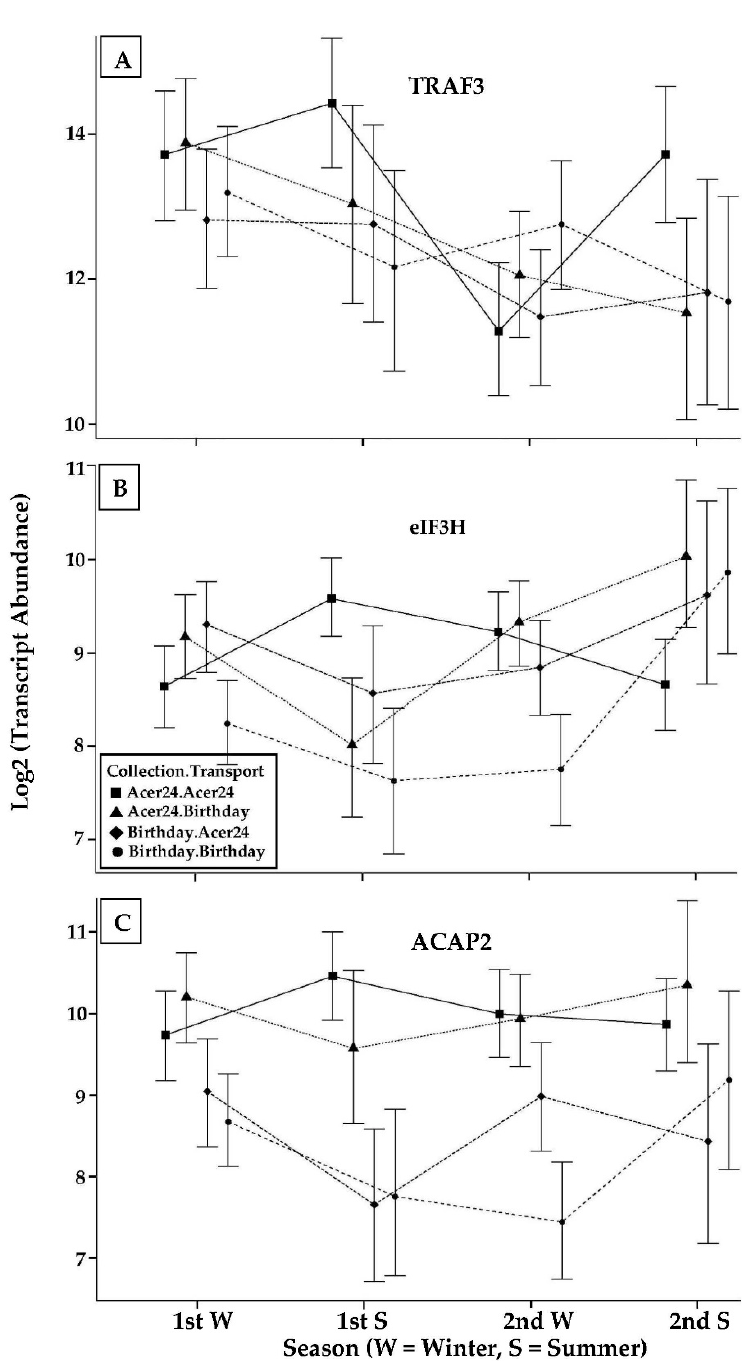
Figure 3. The log2 scaled abundances of ( A ) TRAF3, ( B ) eIF3H, and ( C ) ACAP2 transcripts from corals reciprocally transplanted between an inshore site (Birthday Reef) and an offshore site (Acer24). Samples were collected for analysis during the winter (February) and summer (September) seasons. Points represent the posterior means following MCMC generalized linear mixed modeling. Error bars indicate 95% credible intervals defined by the model. Note: First summer (1st S) and winter (1st W) vs. second summer (2nd S) and winter (2nd W) are shown.